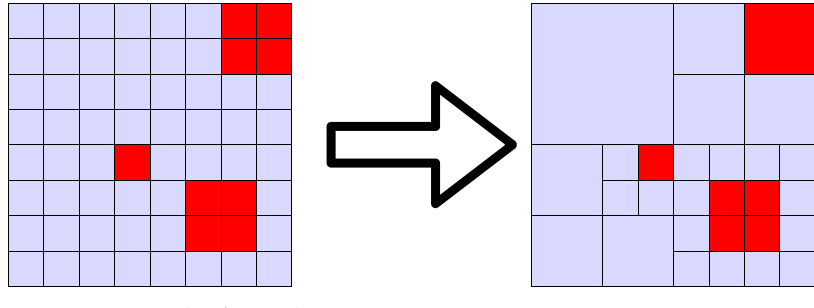
Figure 13. Example of a